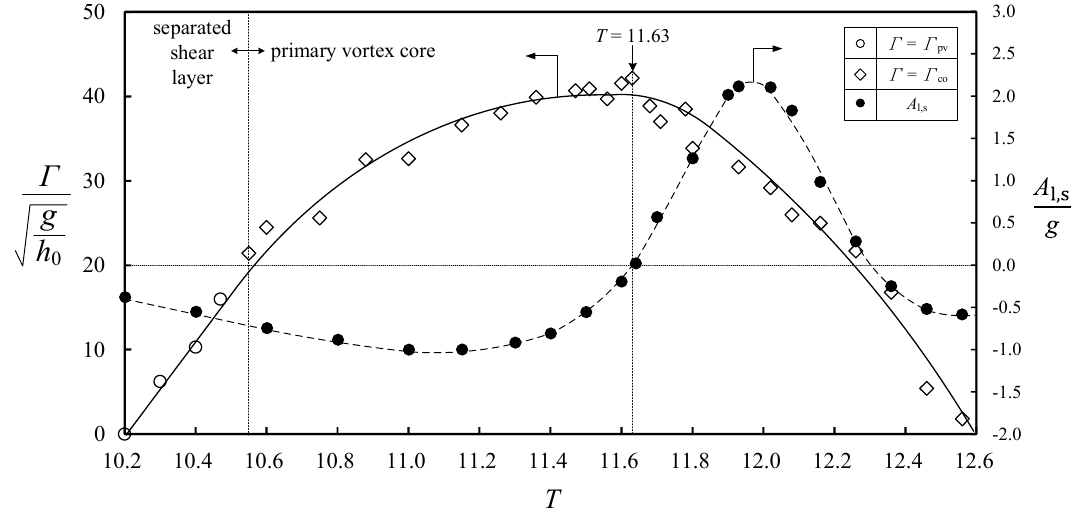
Figure 23. Relationship between the temporal variation in the non-dimensional peak vorticity of the shear layer, Г pv / [ g / h 0 ] 1/2 or the non-dimensional vorticity of the primary vortex core, Г co / [ g / h 0 ] 1/2 and the counterpart in the smoothed value of the local acceleration, A l,s / g , with respect to the non-dimensional time, T , for 10.20 ≤ T < 12.60.